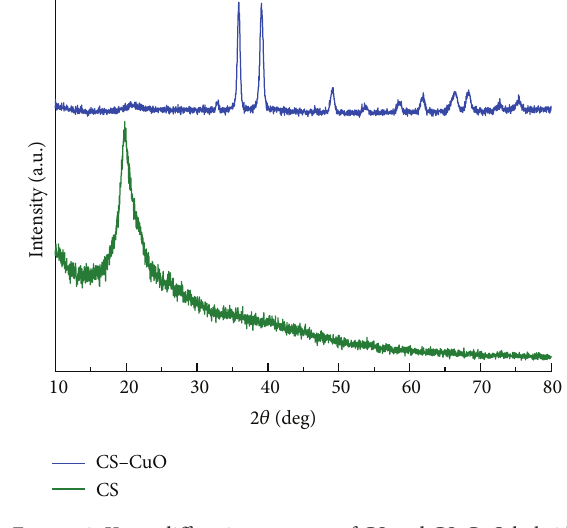
Figure 2: X-ray diffraction patterns of CS and CS-CuO hybrid.